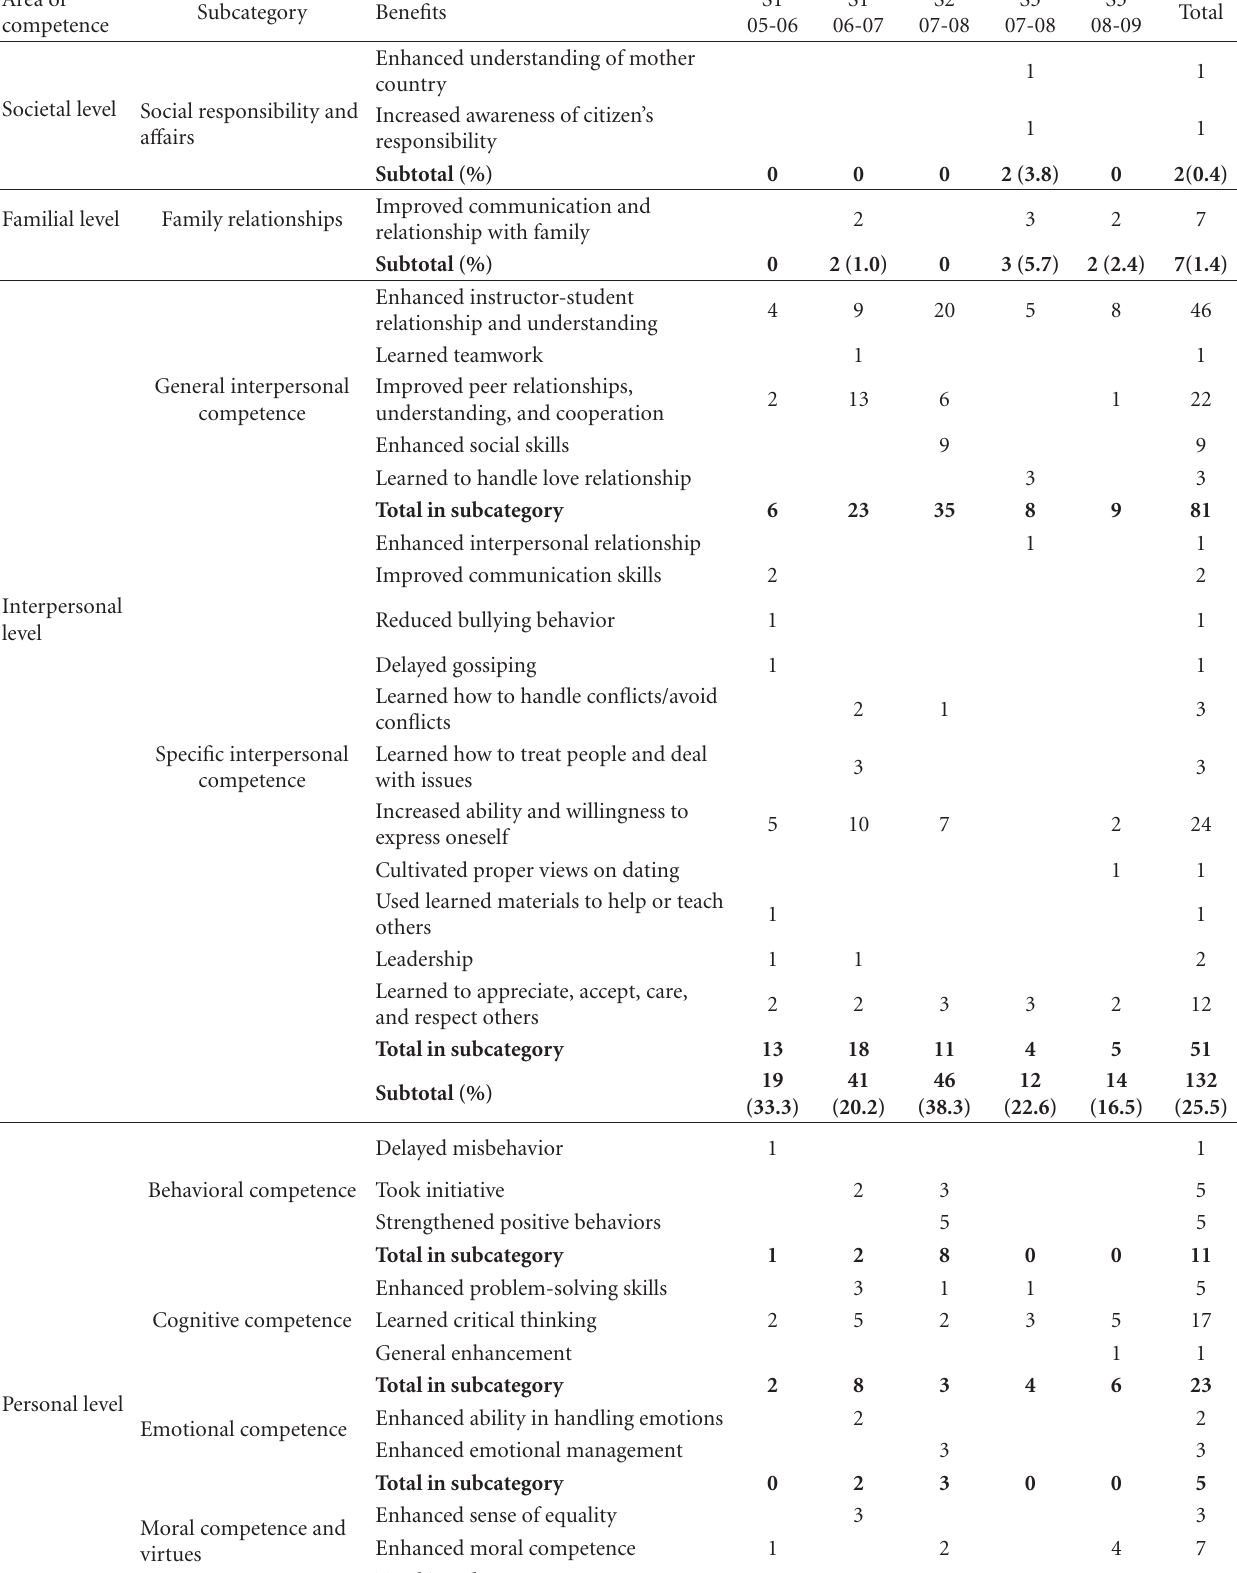
Table 5: Categorization of instructors’ responses on the perceived benefits of the Tier 1 Program. Area of competence